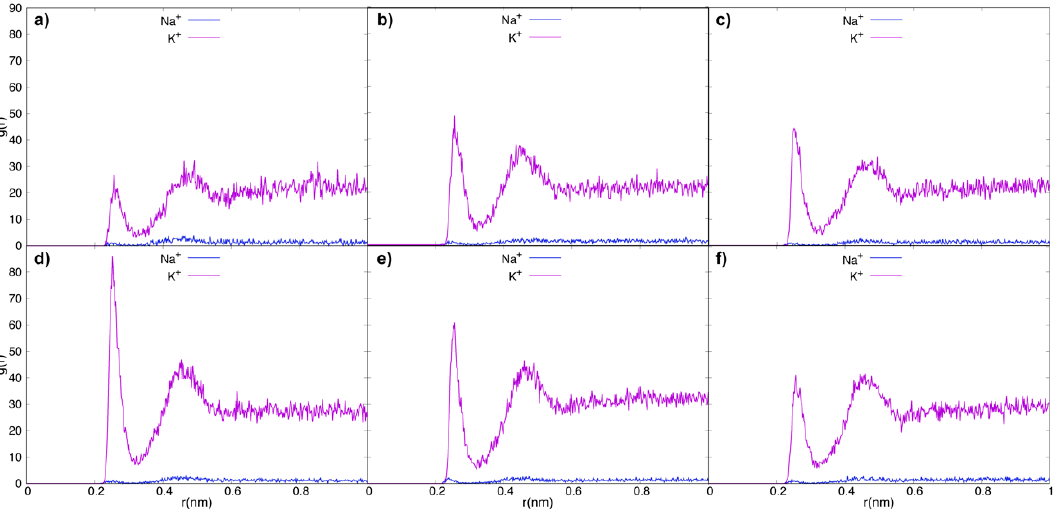
Figure 8. Radial distribution functions (g(r)) of K + and Na + ions in the vicinity of the tau surface, for tau replicates in fluid ( a – c ) and tau::microtubule replicates ( d – f ). Purple trace for potassium and blue trace for sodium.